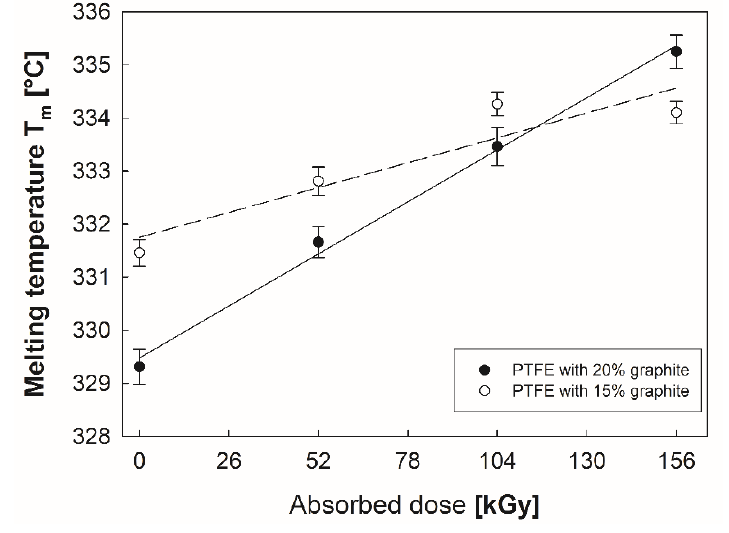
Figure 5. Changes in the melting point temperature of PTFE with 15% and 20% graphite